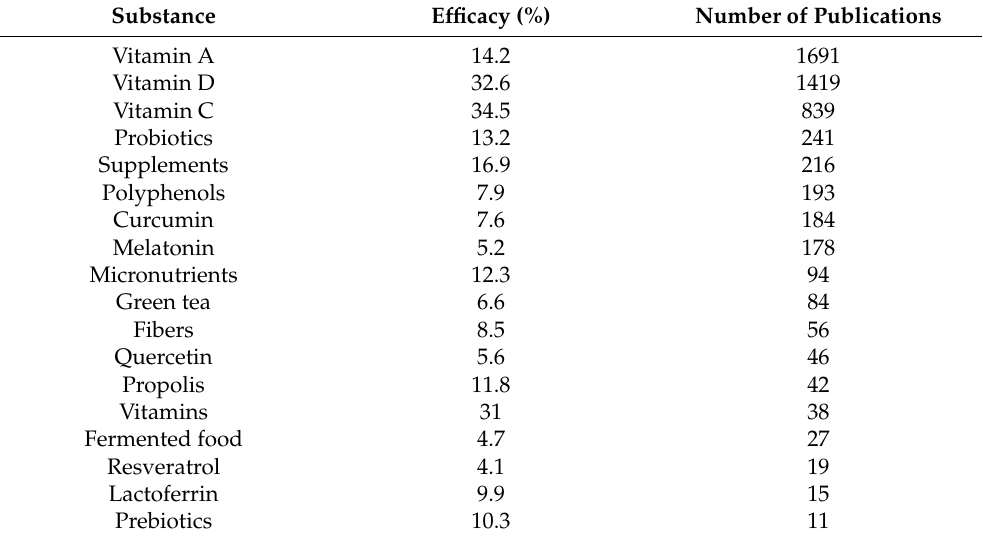
Table 9. Bioactive compound efficacy against COVID-19, according to consumers’ consensus, versus the number of publications related to efficacy against COVID-19 in the Web of Science Platform (WOS) using the search “name of each compound” and “COVID”. Substance Efficacy (%) Number of Publications Vitamin A 14.2